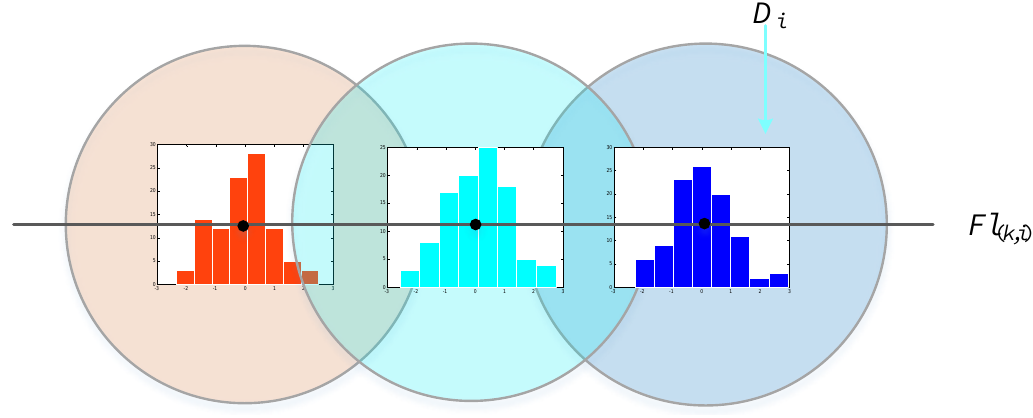
Figure 3. Illustration of constructing our line descriptor.